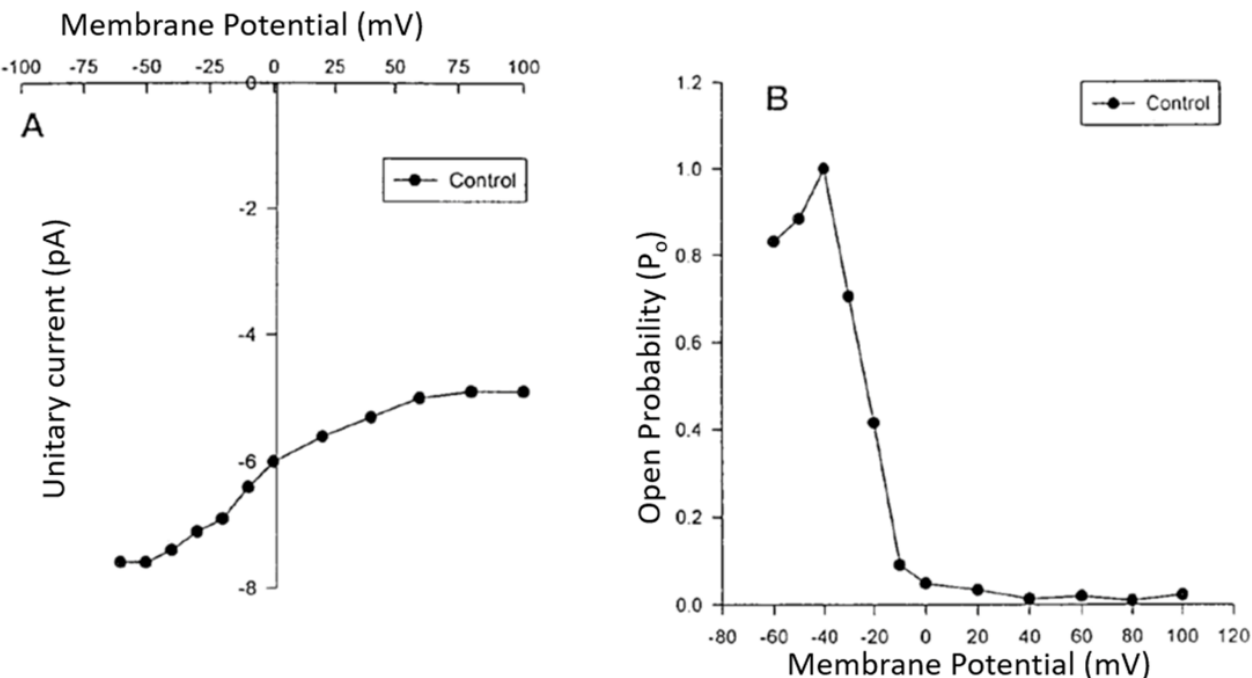
Figure 3. Current to voltage (I/V) relationship curve ( A ) and open probability/voltage relationship ( B ) of the voltage-dependent steady-state R-type Ca 2+ channel in human aortic VSMCs recorded using the patch clamp technique (modified from Bkaily et al. 1997) [44].